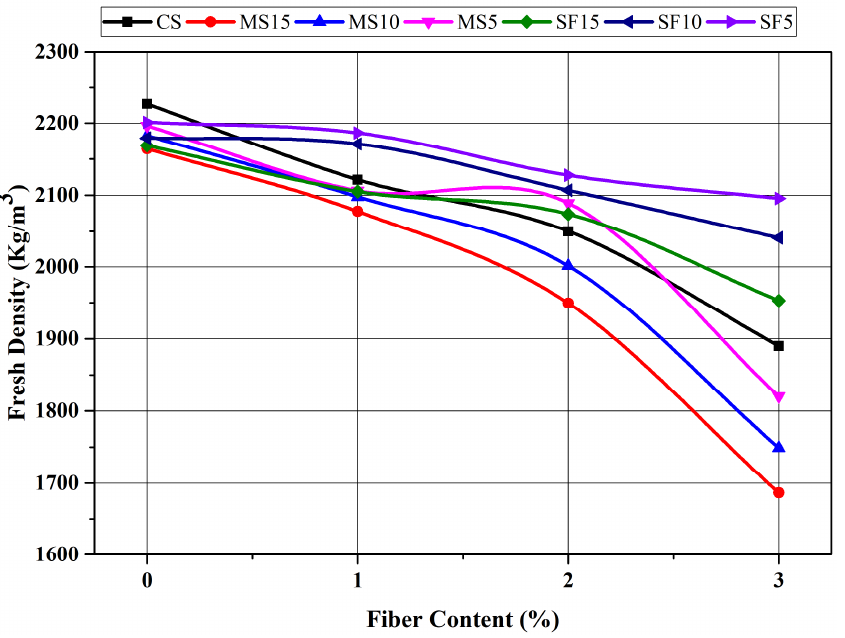
Figure 3. Fresh density values of the mortar samples .